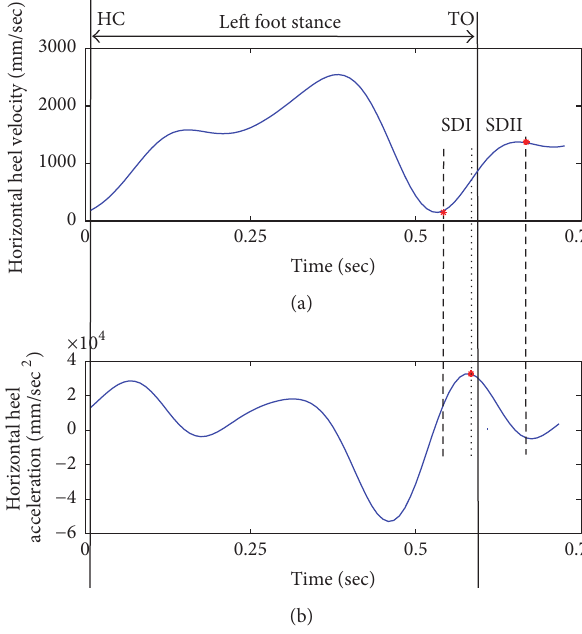
Figure3:(a)Horizontalheelvelocityofslippingfoot.(b)Horizontal heel acceleration of the slipping foot.